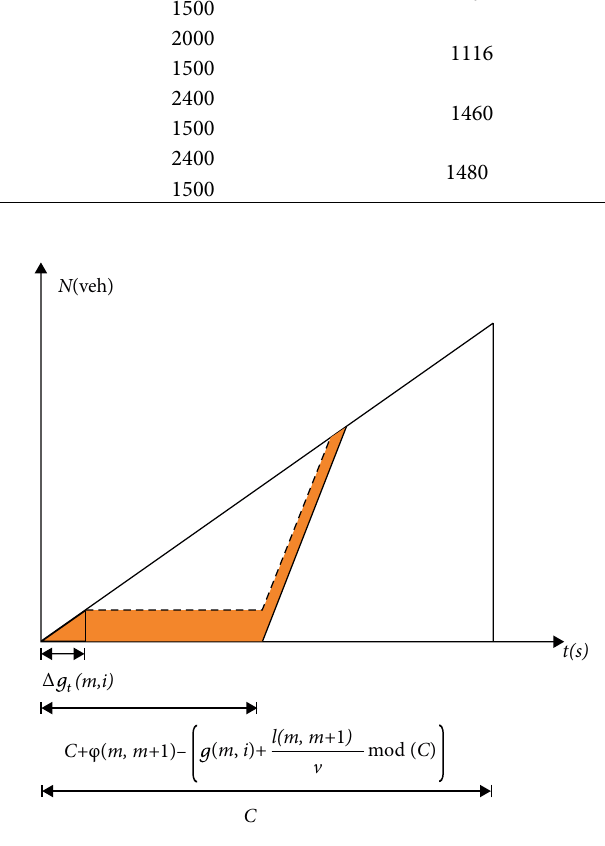
Figure 9: Analysis of all priority vehicle delay at downstream